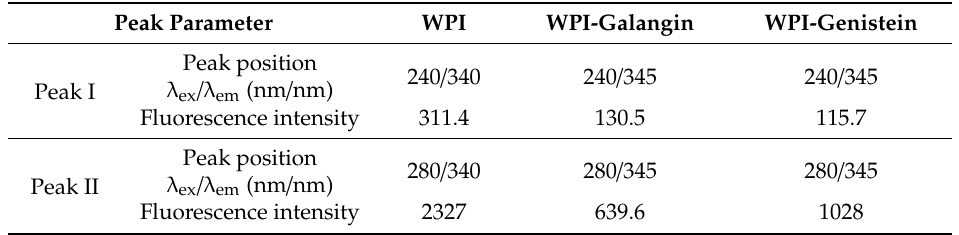
Table 5. 3D fluorescence spectral characteristics of WPI or the WPI-galangin and WPI-genistein complexes.